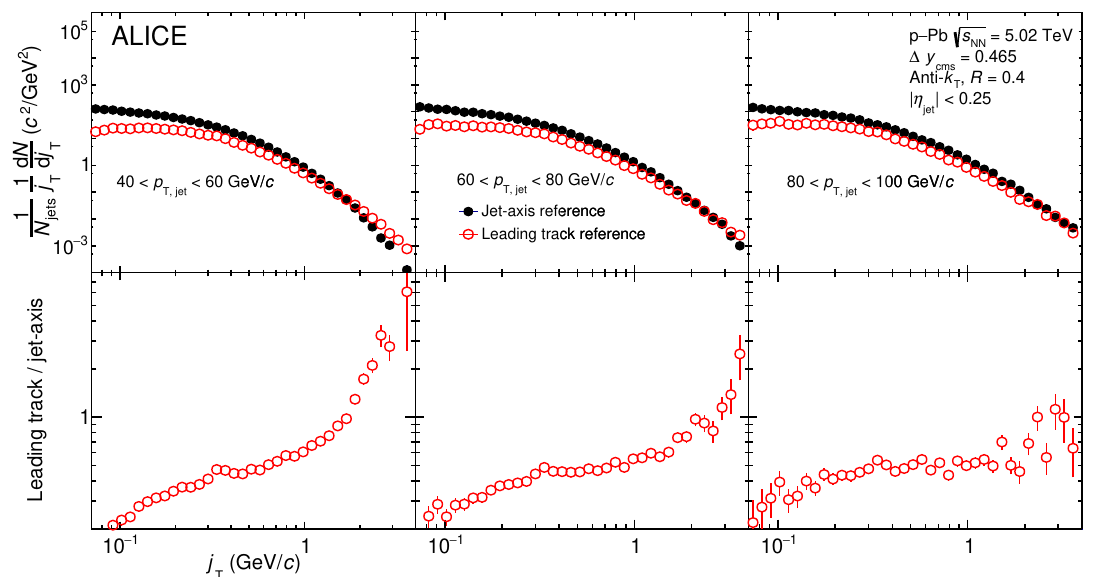
Figure 8. The j T distributions with respect to the leading track momentum (leading track ref- erence) and the jet axis (jet-axis reference) within the same jet for three different p T , jet intervals with R = 0 . 4